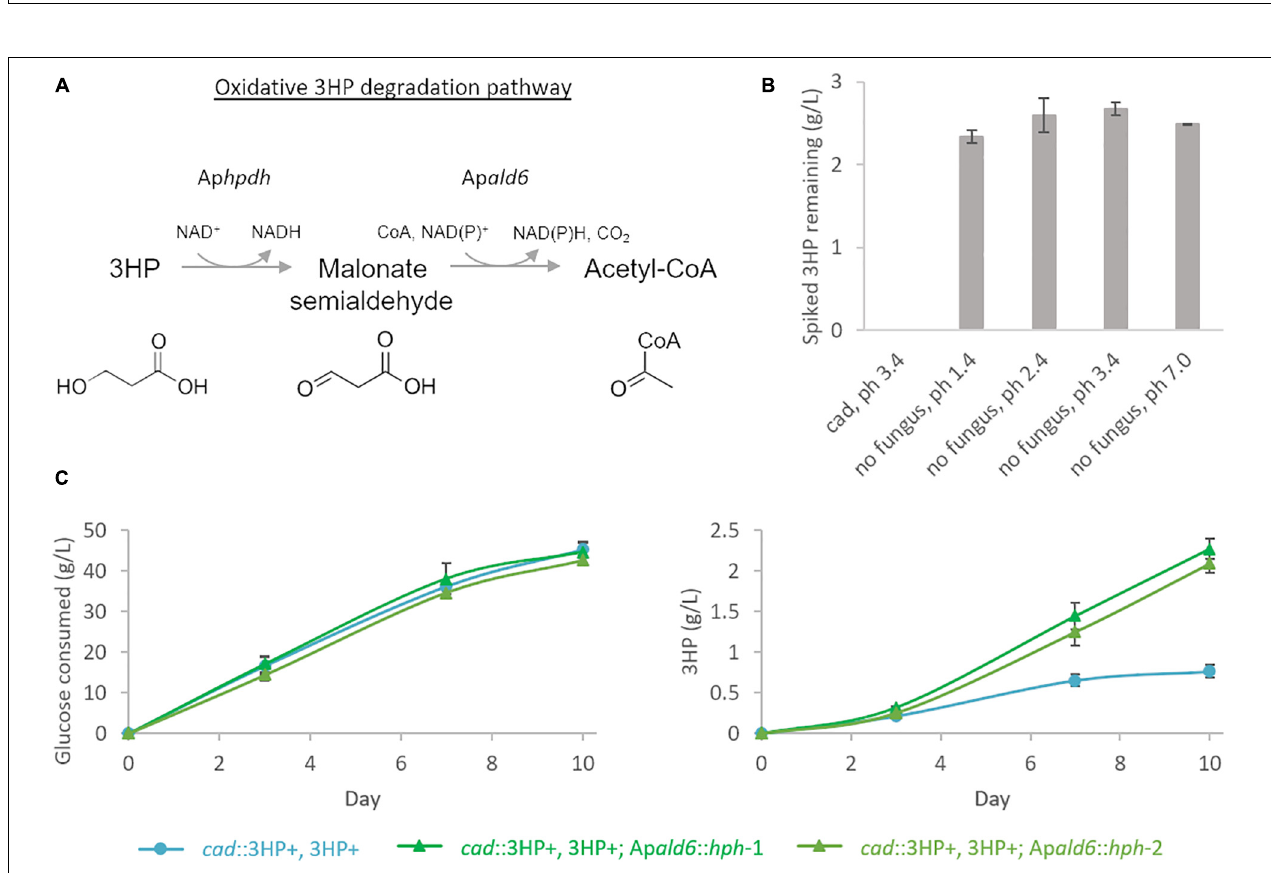
FIGURE 4 | 3HP is degraded biotically through Acetyl-CoA by A. pseudoterreus . (A) Model for 3HP oxidative degradation pathway present in A. pseudoterreus . (B) Shake-flasks were spiked with 3HP and incubated for 5 days at 30 ◦ C with or without the presence of a strain not engineered for 3HP production ( cad ). Uninoculated flasks were examined across a pH range expected to be experienced during A. pseudoterreus growth. The expected abiotic degradation product, acrylic acid was not detected in any flask. 3HP was not detected after 5 days incubation with A. pseudoterreus ( cad ). (C) Deletion of the putative malonate semialdehyde dehydrogenase (Ap ald6 ) improves yield of 3HP from glucose. Two independent deletion mutants are shown.